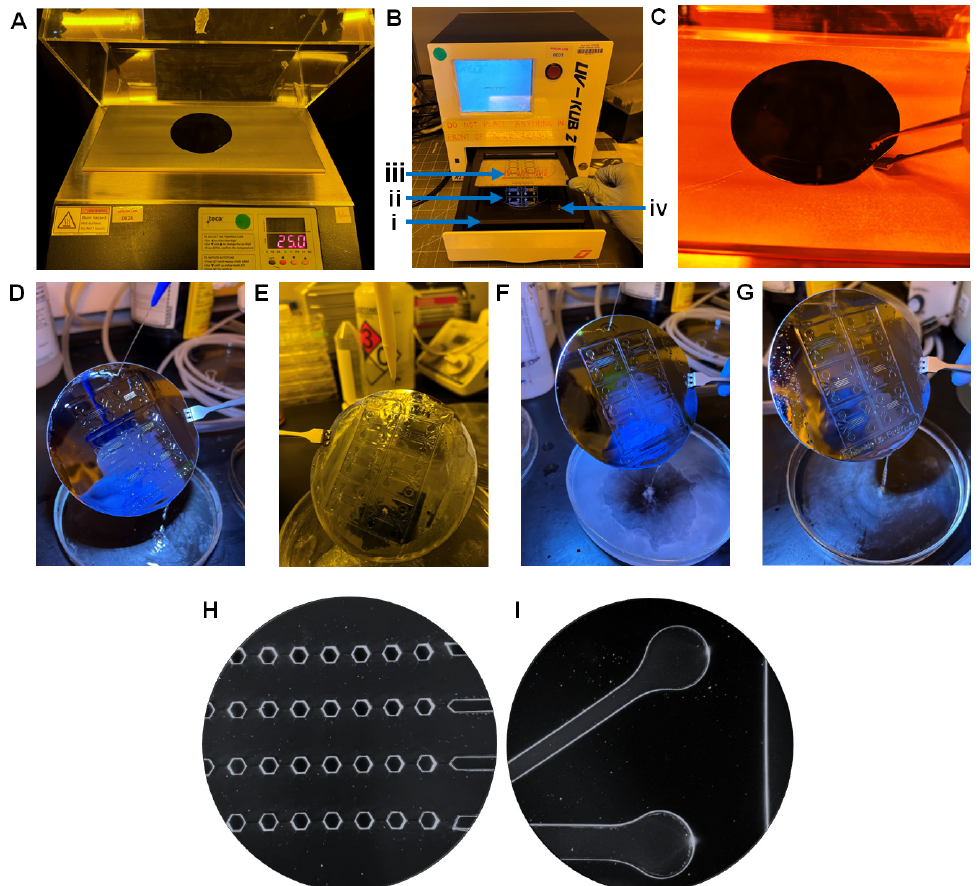
Figure 4 . ( A ) Silicon wafer placed on a controllable heat/cool cold plate such that the entire wafer